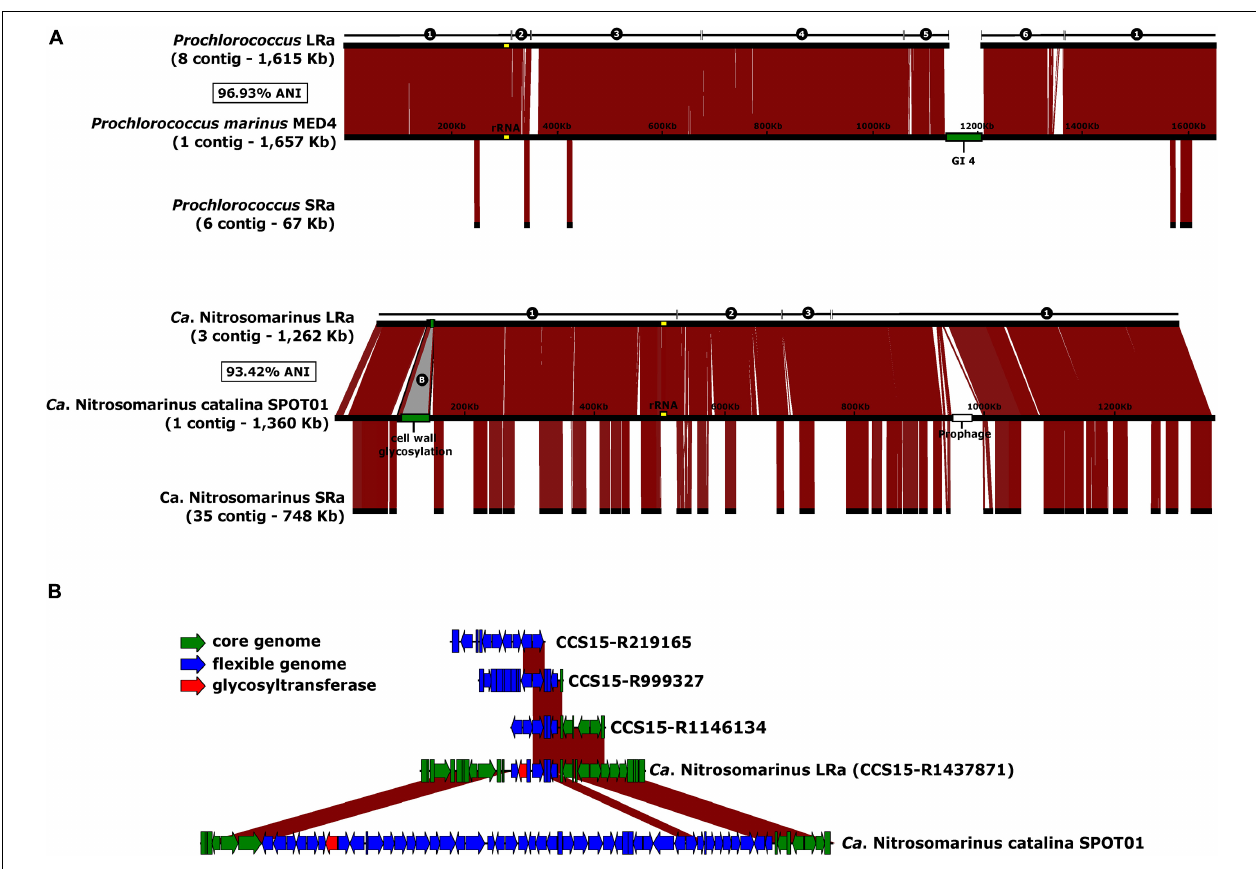
FIGURE 5 | (A) Alignment of the reference genomes Prochlorococcus marinus MED4 and Ca. Nitrosomarinus catalina SPOT01 against the reconstructed MAGs from LRa (above) and SRa (below). Number of contigs, and ANI of the LRa MAGs and the reference genomes indicated to the left. GI4 of P. marinus coding for O-chain polysaccharide synthesis and a putative cell was glycosylation cluster in of Ca. N. catalina are in green. (B) Magnified B region as labeled in A indicating also some syntenic fragments found among CCS15